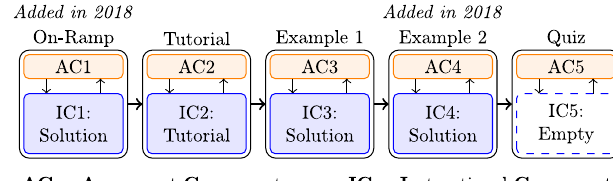
FIG. 2. The sequence of OLMs designed for this experiment. Each OLM contains an assessment component and an instruc- tional component. Students are required to make at least one attempt on the AC first, then are allowed to view the IC, and go on to make subsequent attempts on the AC. OLMs 1 and 4 were added for the 2018